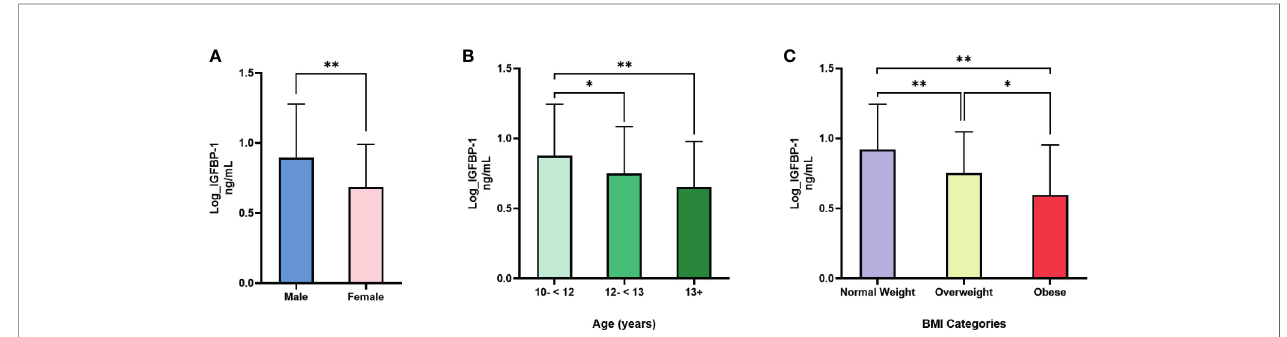
FIGURE 1 | Differences in IGFBP-1 levels based on (A) sex, (B) age and (C) weight status: (A) IGFBP-1 are signi fi cantly lower in females compared to males; N=191 males, 228 females; t=6.18, p<0.001; (B) IGFBP-1 levels are signi fi cantly reduced with age; N=178 (10-<12), 143 (12-<13) and 98 (13+); (C) IGFBP-1 is reduced in overweight and obesity compared to normal weight; N= 198 normal weight, 88 overweight, 135 obese. Data is presented as means ± SD. Males and females were compared by t-test for independent samples, whereas, age groups and weight status groups were compared with one-way ANOVA. *p < 0.01; **p <